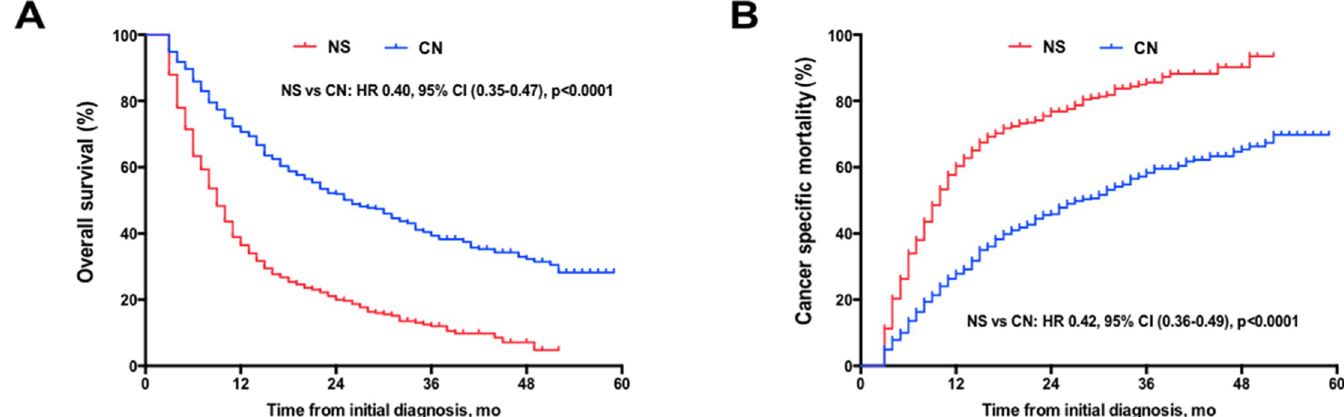
Fig 1. (A) Overall survival and (B) cumulative incidence of renal cell carcinoma (RCC)-specific mortality in patients with metastatic RCC at diagnosis based on treatment received in full samples. NS = no surgery therapy; CN = cytoreductive nephrectomy.